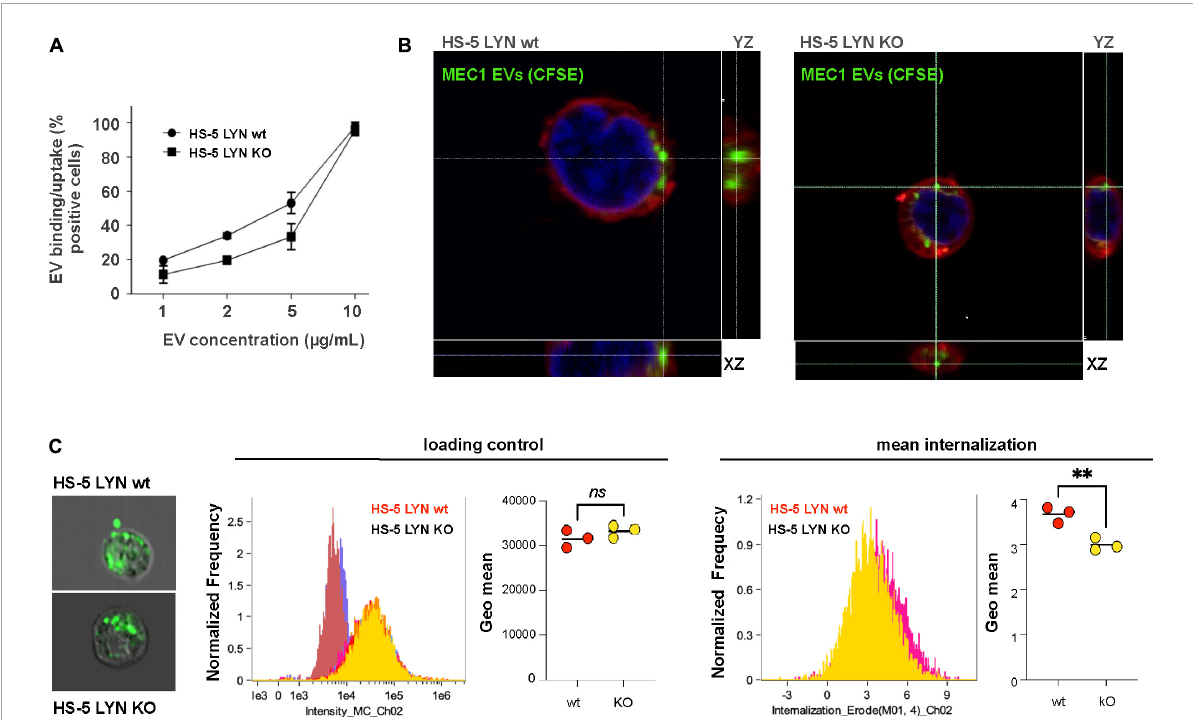
FIGURE3 Influence of Lyn from stromal cells on the extracellular vesicles (EV) uptake. (A) The uptake/binding of EVs from MEC-1 cells (chronic lymphocytic leukemia, CLL) was tested in Lyn-proficient and Lyn-deficient HS-5 cells. EVs from MEC-1 cells were isolated by ultracentrifugation for 90 min at 110,000 × g , stained with DiD and washed with PBS. Both HS-5 cell types were cultivated for 24 h in the presence of a dilution series (1–10 µ g/ml) of these EVs. Then, the cells were washed and analyzed by flow cytometry. (B) Confocal microscopy of Lyn-proficient and Lyn-deficient HS-5 cells with CSFE-labeled MEC-1 EVs. Cells were incubated with labeled EVs and the cell membrane was subsequently stained with CellMask deep red. (C) The internalization process was further analyzed by imaging flow cytometry investigation of 10,000 wt and Lyn-deficient HS-5 cells. Representative images are shown of Lyn-proficient (upper left) and Lyn-deficient HS-5 cells (lower left), incubated with CSFE-labeled EVs for 60 min at 37 ◦ C. The loading controls of three independent experiments with their geo means are shown in the middle panel and the internalized intensity (internalization erode) of the green fluorescence with the geo means is depicted (right panel). The results were statistically evaluated by a two-tailed, parametric t -test (Mann–Whitney) ( ∗∗ P < 0.01, ns, not